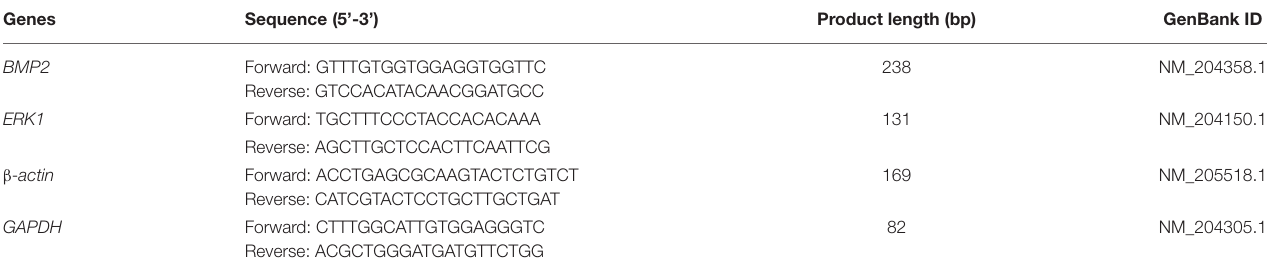
TABLE 2 | Primers used for the target and reference genes (experiment